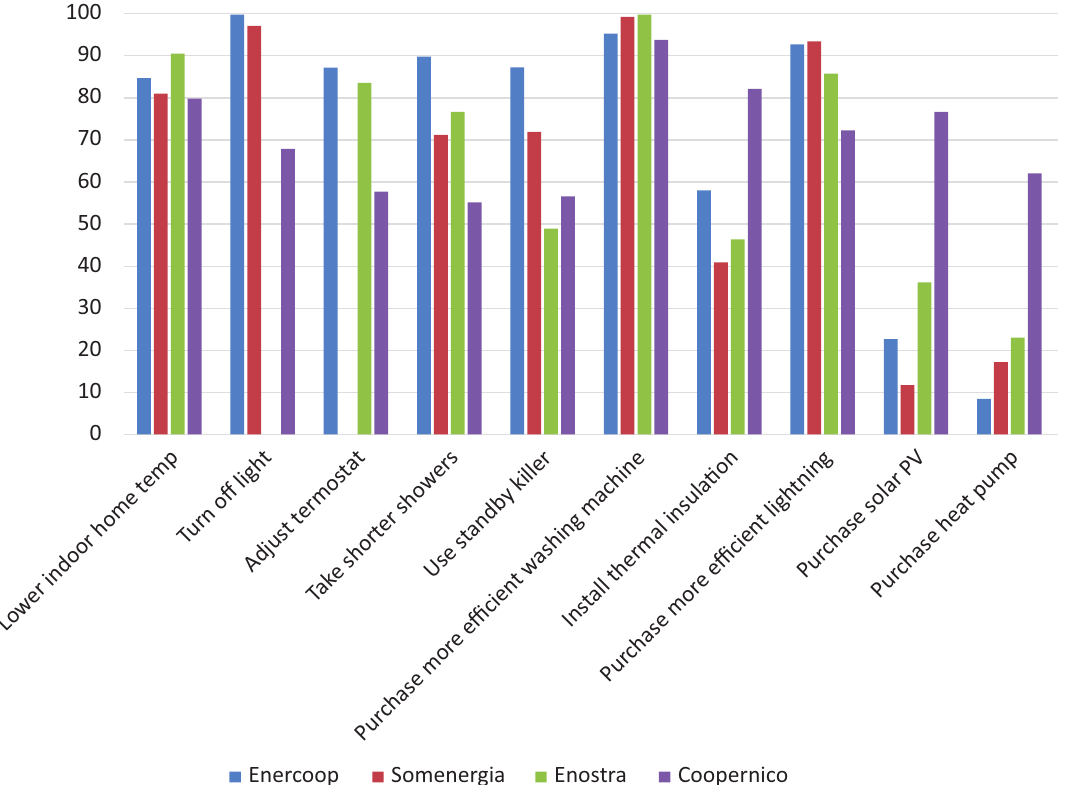
Figure 7. Response, in %, to the 2018 survey item about engagement in particular energy‐saving behaviour (per REScoop). were found to consume 13% less electricity than